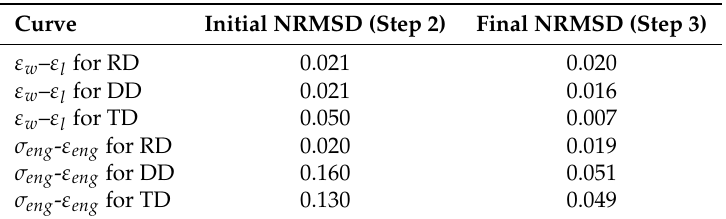
Table 4. Normalized root mean square deviation (NRMSD) in the ε w – ε l and σ eng - ε eng curves. Curve